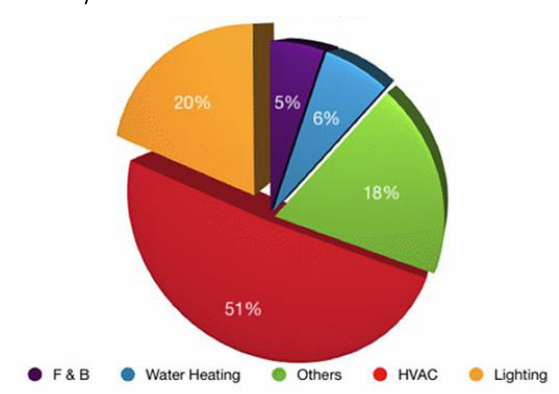
Figure 1. Global Electrical Consumption